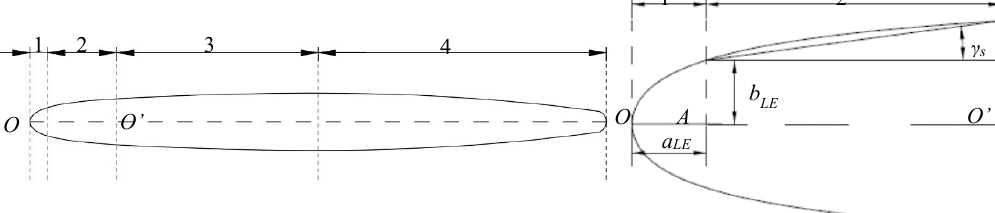
Figure 4. Geometry deconstruction and parameters of the Diffusion angle Integral method: 1—Elliptical arc section; 2—Thickness diffusion section; 3—Thickness transition section; 4—Thickness reduction section.